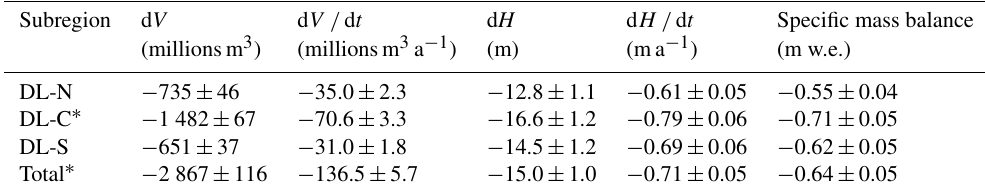
Table 2. Volume changes, elevation changes, and mass balance of glaciers in subregions of Dickson Land over the period